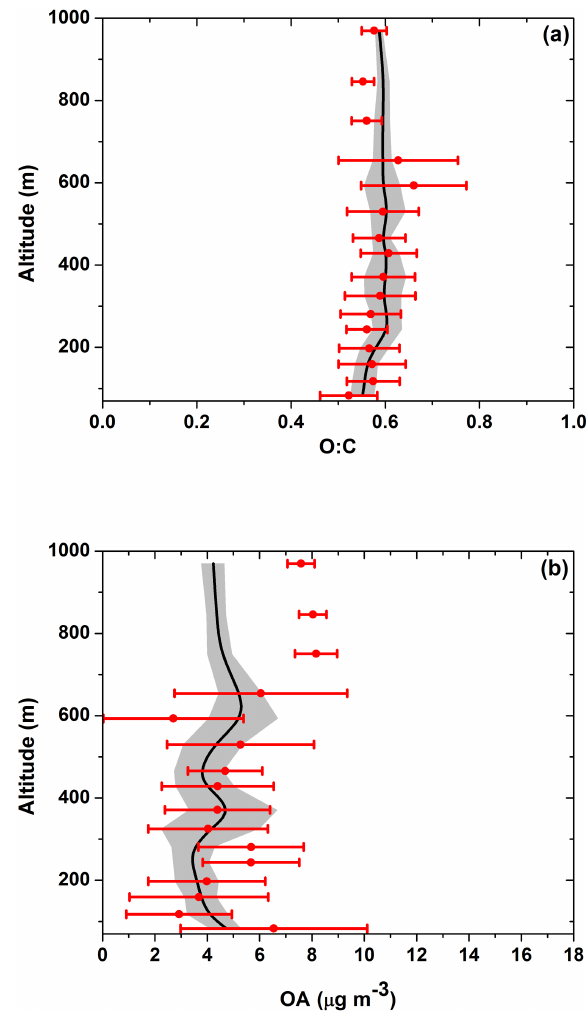
Figure 3. Average vertical predicted and measured (one-bin case, as an example) (a) O : C ratio and (b) organic aerosol mass concen- tration for all the Zeppelin measurements over the Po Valley. The black line shows the model predictions and the shaded areas the standard deviation. The red symbols represent the AMS Zeppelin measurements and the error bars correspond to 1 standard devia- tion. The discontinuity at the top is due to the results of a single flight on 20 June